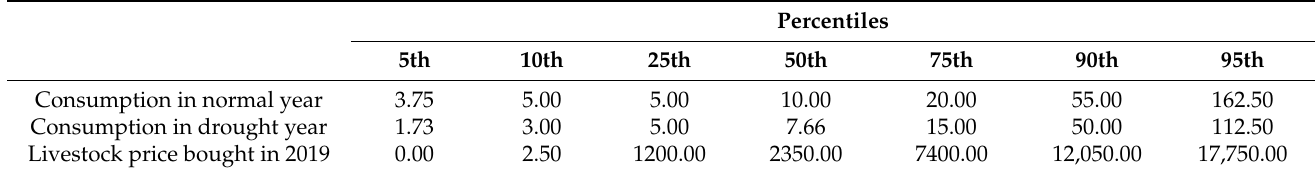
Table 7. Distribution of expenditure and consumption of respondents in the FBDM.